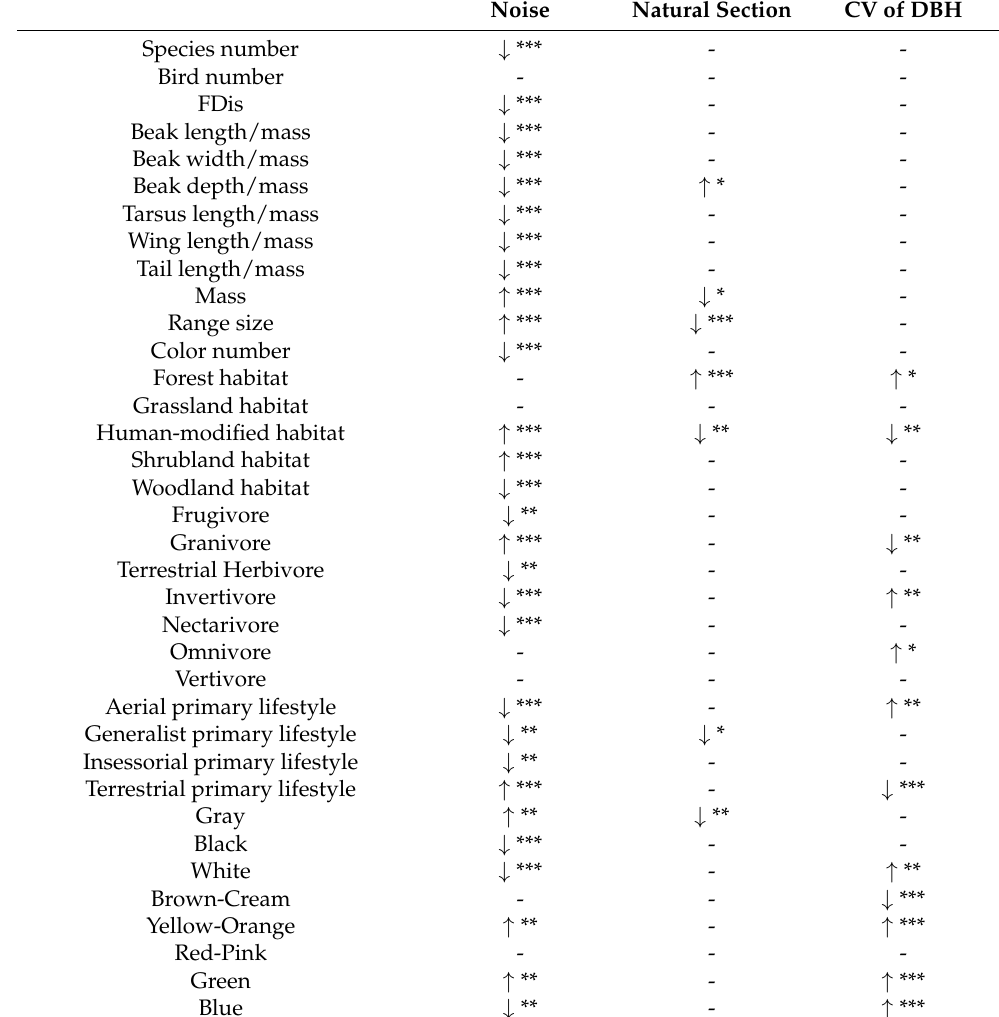
Table 3. Summary of the effects of the three explanatory factors selected in the CRA—noise, section type (natural section), and coefficient of variation of the diameter at breast height (CV of DBH)—on the traits describing bird communities (model summaries in Tables S7 and S8). Direction ( ↑ / ↓ )